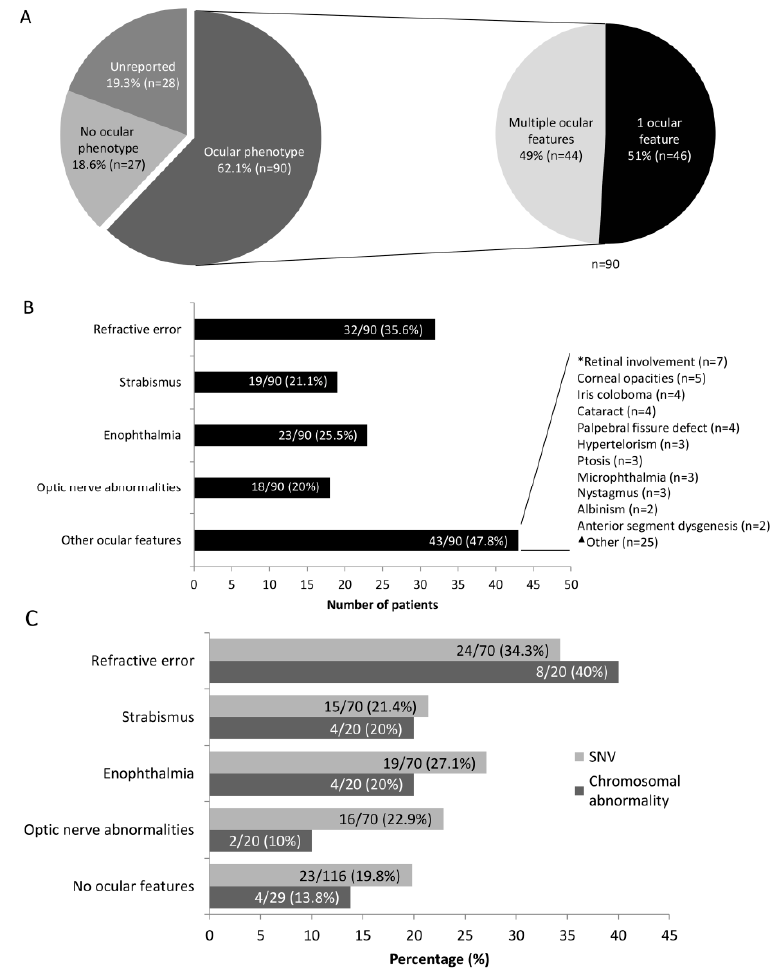
Figure 2. Ocular features reported in patients with DYRK1A- related intellectual disability syndrome and genetic diagnosis. ( A ) Ninety patients are reported with one or multiple ocular features. ( B ) Ocular features were divided into five categories; refractive error (including hyperopia/hypermetropia, myopia, astigmatism) was observed in 32 patients, strabismus (including exotropia, exophoria, esotropia, pseudo-exotropia) in 19 patients, enophthalmia (including sunken eye appearance and deep-set eyes) in 23 patients, optic nerve abnormalities in 18 patients and other ocular features in 43 patients. Within the other ocular features group * retinal involvement was seen in 7 patients including retinal detachment ( n = 2, occurred at 4 months of age in a male patient with bilateral microphthalmia, and in a second female patient age 59 years with no other clinical details), retinal dystrophy ( n = 2), abnormal fundus findings ( n = 3). ▲ Other included non-specific terms such as visual impairment ( n = 7) and abnormality of the eye ( n = 4), cortical visual impairment, photosensitivity, congenital nasolacrimal duct obstruction ( n = 2), blepharophimosis, sclerocornea. ( C ) Comparison of ocular features between patients with DYRK1A SNV and chromosomal abnormalities across the 4 main categories, including refractive error, strabismus, enophthalmia and optic nerve abnormalities. In addition, we highlight the number of families that had no reported ocular features amongst the two groups. Overall, no statistical difference was seen between the two mutation groups using chi squared test. Patients with DYRK1A SNV only ( n = 116) and chromosomal aberrations ( n = 29)